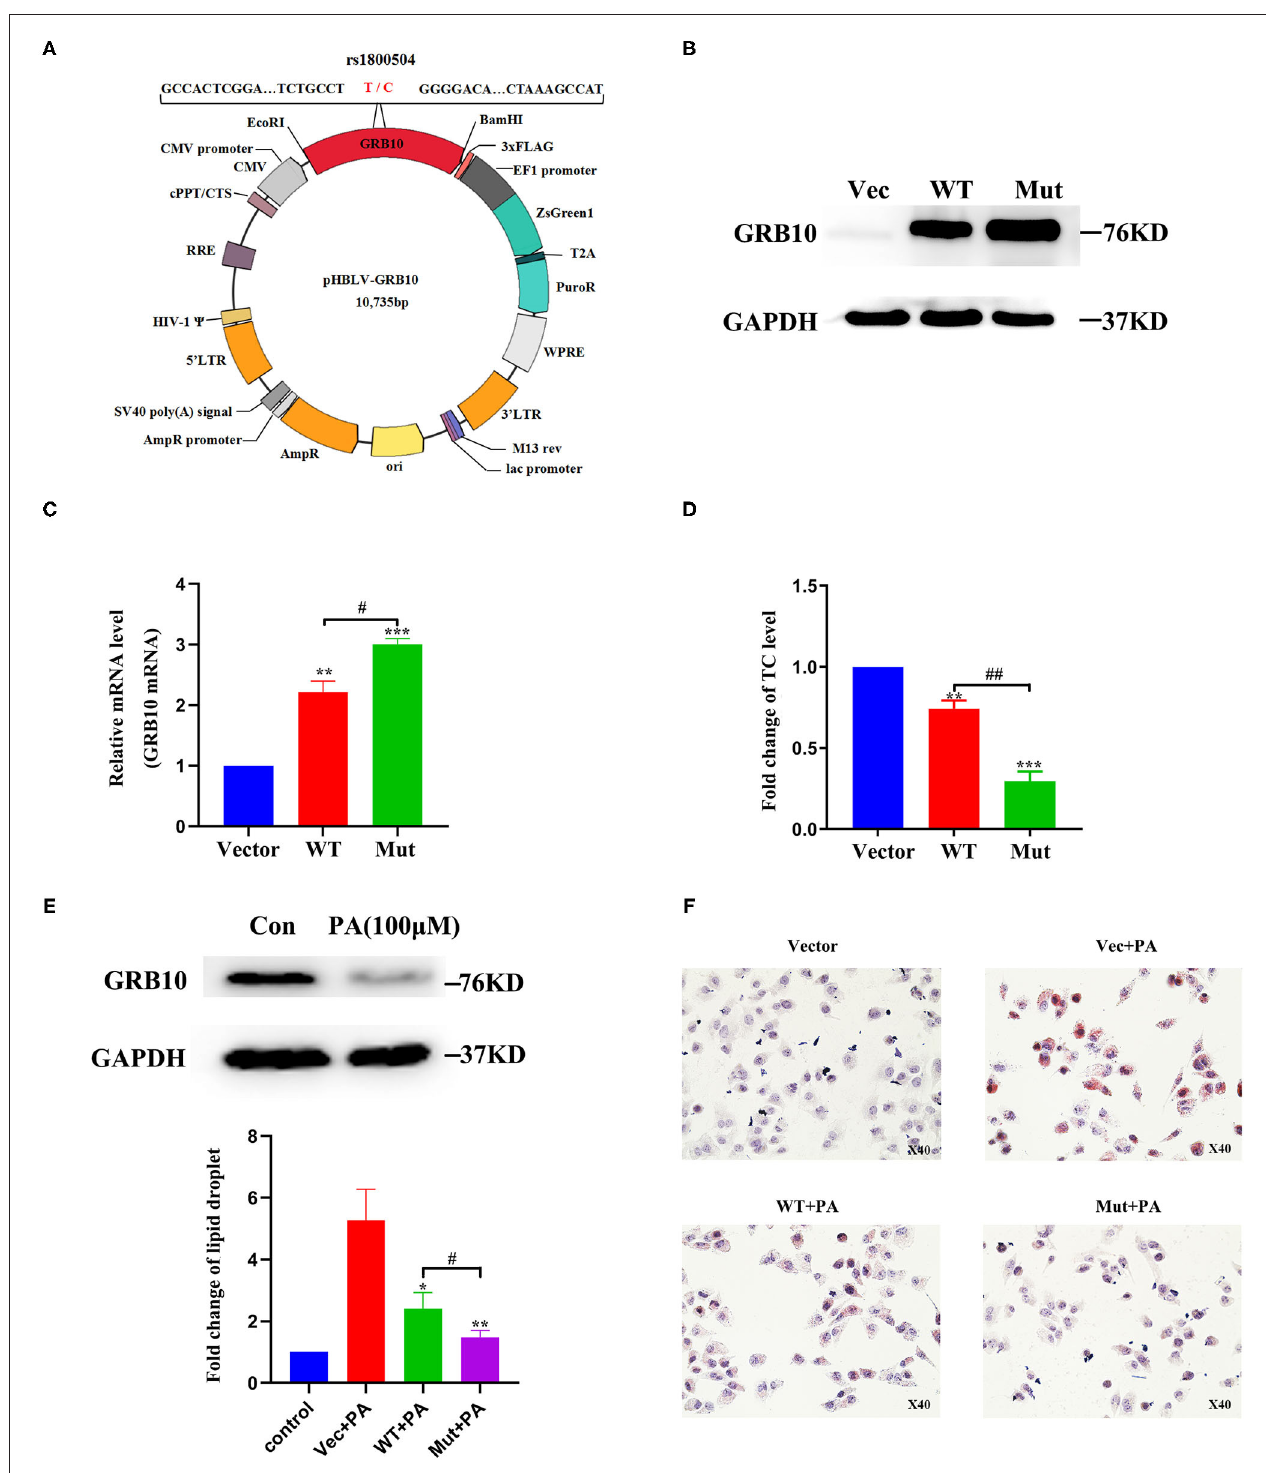
FIGURE 3 | The role of GRB10 rs1800504 mutation in MIHA cells. (A) Diagram showing the constructed vectors pHBLV-rs1800504-C and pHBLV-rs1800504-T. (B) GRB10 protein expression in MIHA cells, as determined by western blotting after the transfection of GRB10 rs1800504 lentivirus. (C) GRB10 mRNA expression in MIHA cells assayed by q-PCR after transfection. (D) The levels of TC in MIHA cells transfected with GRB10 -vector, GRB10 -WT, and GRB10 -Mut. (E) GRB10 expression in MIHA cells after 48h of treatment with PA (100 µ M). (F) Lipid droplet formation in MIHA cells transfected with GRB10 -vector, GRB10 -WT and GRB10 -Mut after treatment with PA (100 µ M) for 48h. * p < 0.05, ** p < 0.01, and *** p < 0.001 represent significantly differences compared with GRB10 -vector. # p < 0.05 and ## p < 0.01 represent significant differences compared with the GRB10 -WT ( n = 3).